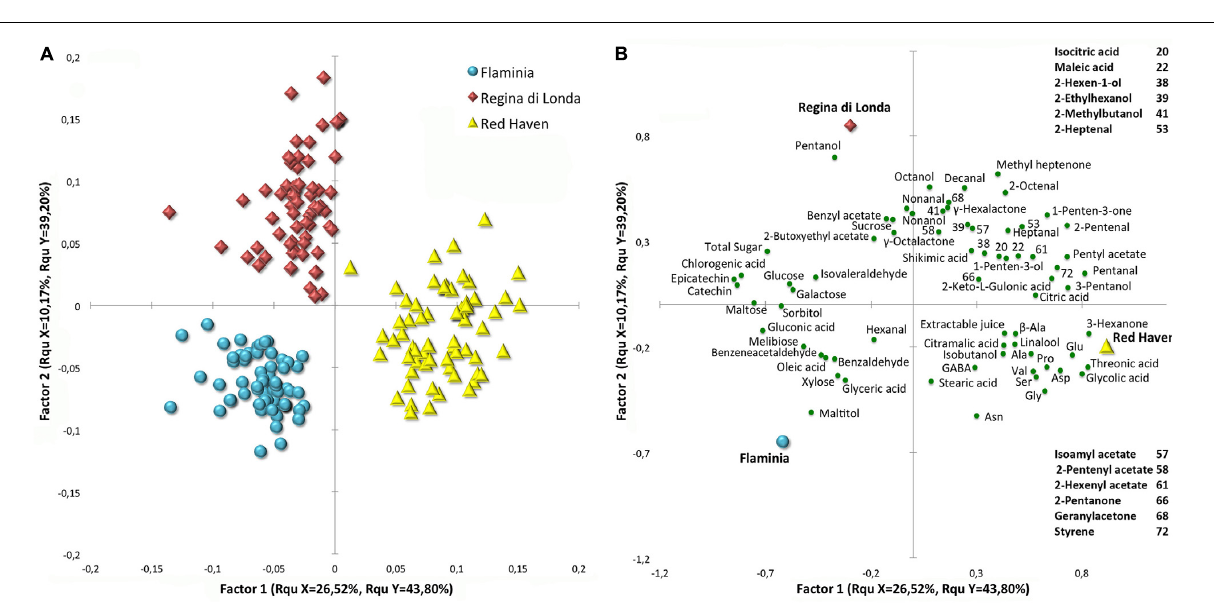
FIGURE 4 | Score (A) and loading (B) plots of a PLS-DA analysis performed with the whole dataset, including cold storage and shelf-life experiments together. All the detected compounds were employed as predictor variables and cultivar as response variable. Important features have been filtered using VIP (Variable Importance in Projection) scores and are reported in the loading plot (B) as green circles. Blue circles, red diamonds, and yellow triangles represent ‘Flaminia,’ ‘Regina di Londa,’ and ‘Red Haven’ peaches,